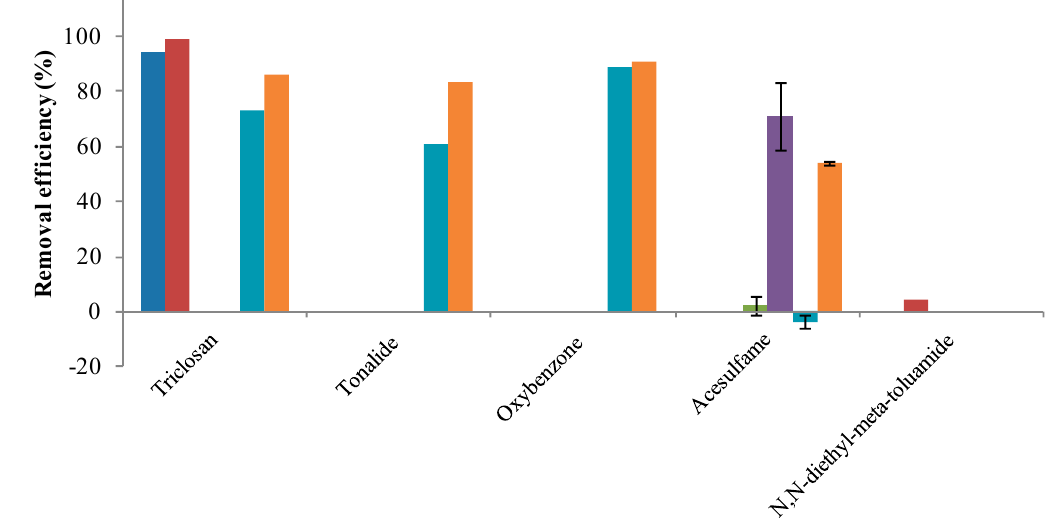
Figure5. Removale ffi ciencyofPCPsindi ff erenttypesofaerated(AA)andnon-aerated(NA)CWs. Figure 5. Removal efficiency of PCPs in different types of aerated (AA) and non-aerated (NA) CWs. Note: Data is taken from: Ávila et al. [22]; Li et al. [21]; Kahl et al. [17]; and Nivala et al. [18]. The enhanced removal is explicit in the case of AA-FWSCW (triclosan), AA-HFCW (acesulfame), AA-VFCW (triclosan, tonalide, oxybenzone, and acesulfame) compared with their corresponding NA-CWs.